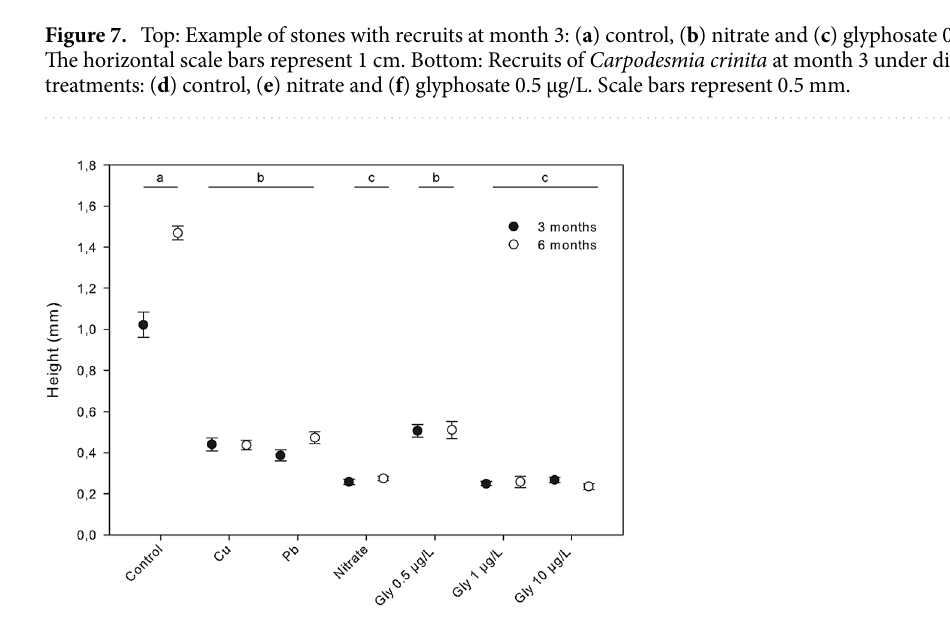
Figure 8. Mean height of recruits of Carpodesmia crinita under control conditions and the different pollutant treatments at months 3 (black dots) and 6 (empty dots) after the beginning of the experiment. Vertical bars represent standard errors. Horizontal lines indicate the significant differences between